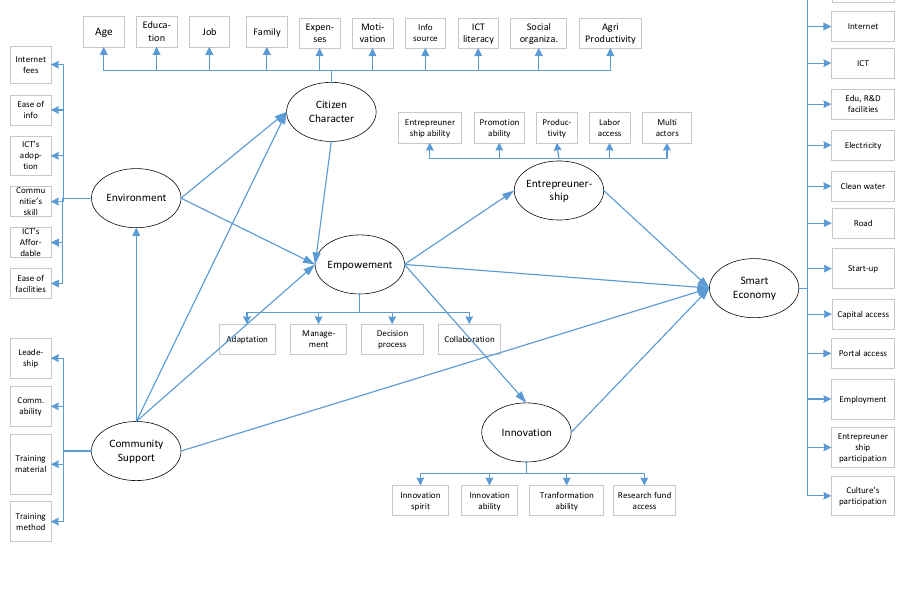
Fig. 2. Conceptual